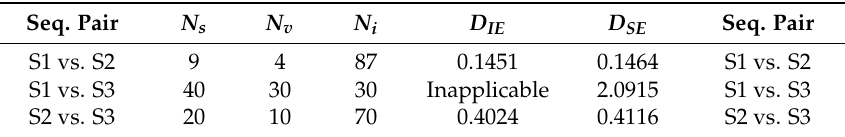
Table 1. Observed number of sites between two sequences that are (1) identical ( N i ), (2) different by a transition ( N s ), and (3) different by a transversion ( N v ) from pairwise comparisons among three sequences (S1, S2, and S3) of length 100. Independently estimated K80 distances ( D IE ) and simultaneously estimated K80 distances ( D SE ) from the maximum likelihood (ML) framework are included. Note that K80 distance cannot be computed for S1 and S3 using independent estimation method (labelled as ‘inapplicable’). Seq. Pair N s N v N i D IE D SE Seq. Pair S1 vs. S2 9 4 87 0.1451 0.1464 S1 vs. S2 S1 vs. S3 40 30 30 Inapplicable 2.0915 S1 vs. S3 S2 vs. S3 20 10 70 0.4024 0.4116 S2 vs.